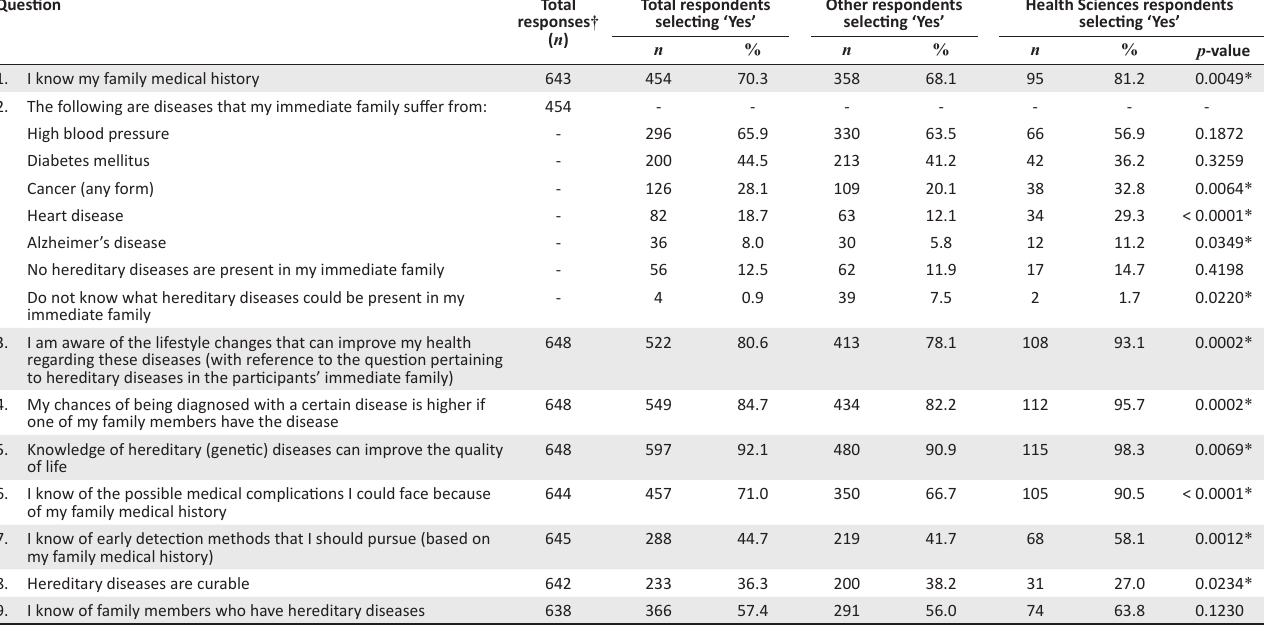
TABLE 2: Respondents’ knowledge about family medical history of hereditary diseases.